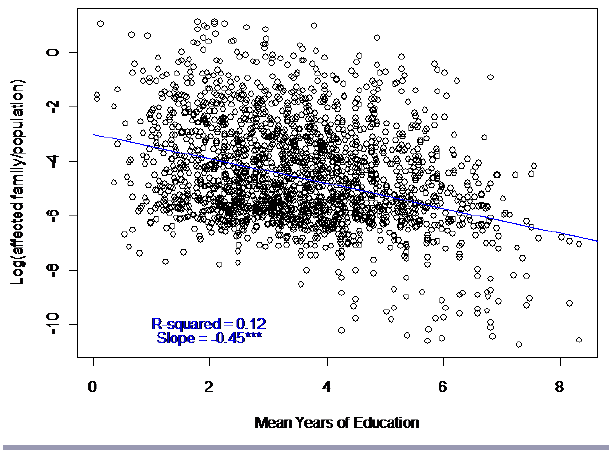
Fig. 5 . Log of the ratio of number of affected families and size of the population and the mean years of education of population aged 15 to 19 at the community level.